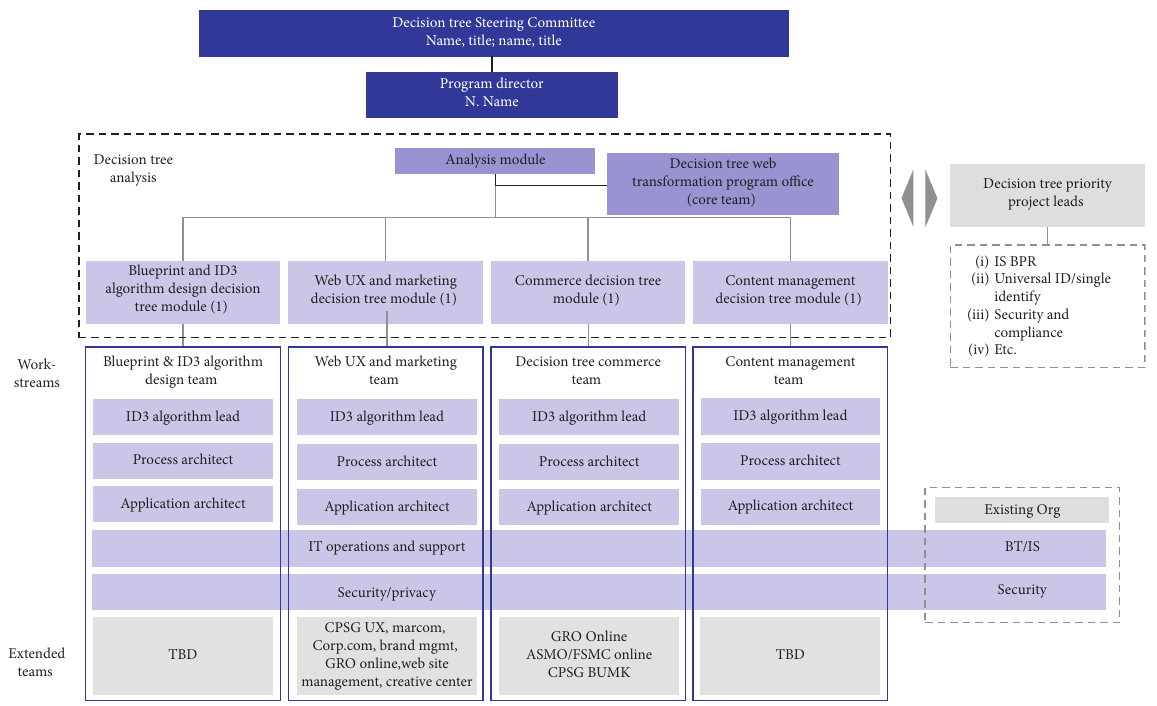
Figure 2: The decision diagram of ID3 algorithm.